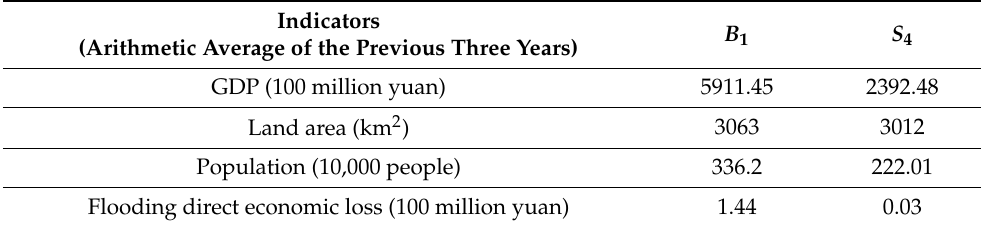
Table 3. Data on the unfair pullback coefficient of GDP for B 1 and S 4 .